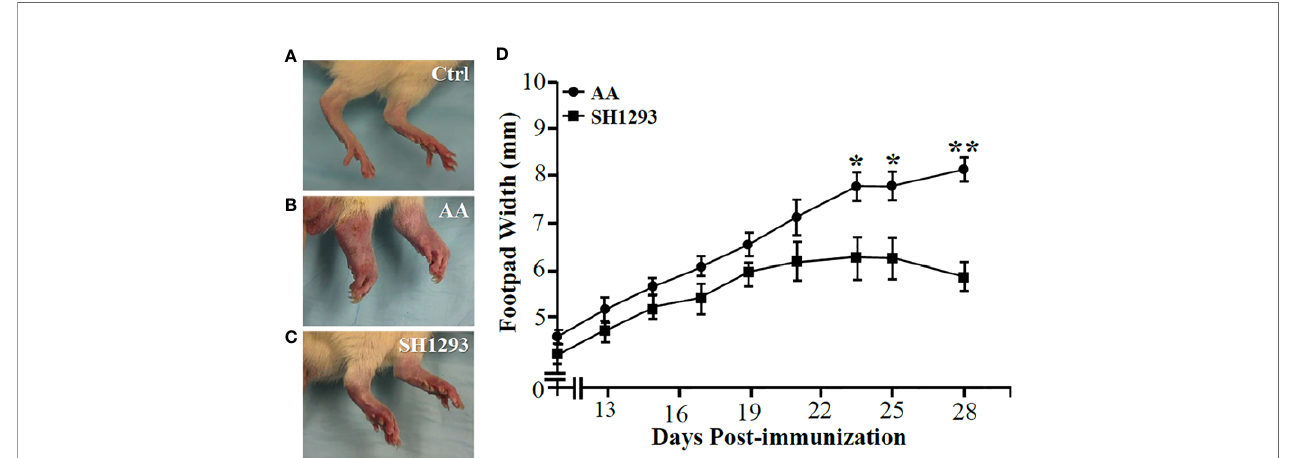
FIGURE 2 | SH1293 Suppressed Arthritis in the Hind limbs (A – C) and Reduced Footpad Widths (D) . (A – C) Hind feet images at the study endpoint (D28) from non- treated controls [Ctrl; (A) ], vehicle-treated arthritic rats [AA; (B) ], and SH1293-treated arthritic rats [SH1293; (C) ]. (A) Non-arthritic Ctrl rats illustrate normal appearance of the hind limbs. (B) Vehicle-treated AA rats developed severe arthritis with severe swelling, erythema, joint stiffness, and deformities of the ankle and foot joints. (C) Arthritic rats treated with SH1293 developed a less severe arthritis, based on reduced swelling, erythema, reduced joint stiffness, and less hind foot deformities compared with vehicle-treated AA rats. (D) This graph plots the dorsoplantar foot pad widths (expressed as a mean of the right and left foot pad) from male Lewis rats across time after immunization with CFA to induce arthritis. Disease onset occurred at D12; severe disease is established at D28. Mean dorsoplantar widths increased through D21; no signi fi cant differences in mean dorsoplantar footpad widths was observed between AA and SH1293-treated rats before D22. By D24, soft tissue swelling was signi fi cantly less in SH1293-treated compared with vehicle-treated AA rats, a fi nding that continued through D28. Non-arthritic Ctrl rats maintained an average footpad with of 20 ± 0.2 mm (data not shown). Graphed data are presented as mean dorsoplantar width in millimeters ± SEM with an n of 8 rats per treatment group. Kruskal-Wallis analysis of the data was followed by Dunn post-hoc testing ( * , p < 0.05; ** , p <